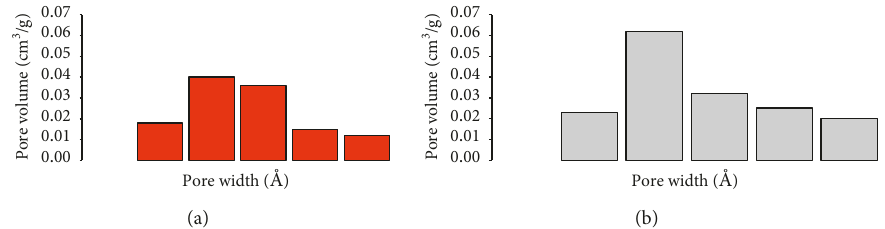
Figure 4: Pore volume distributions by applying Monte Carlo simulation to CO